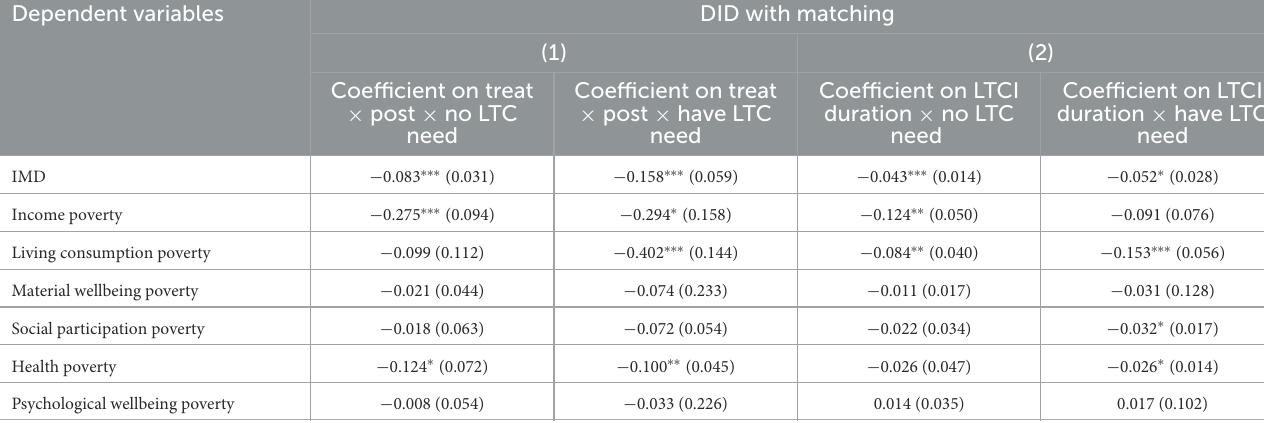
TABLE 5 Effect of LTCI with LTC need and without LTC need. Dependent